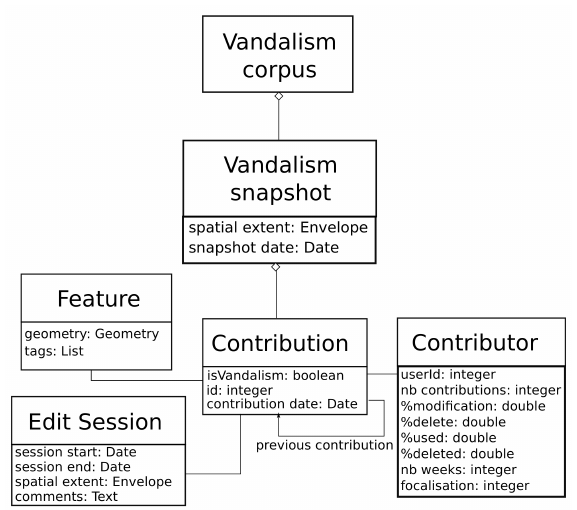
Figure 2. UMLdiagram of the proposed corpus. The corpus is composed of OSM snapshots containing some vandalised contribution, but mostly normal contributions.